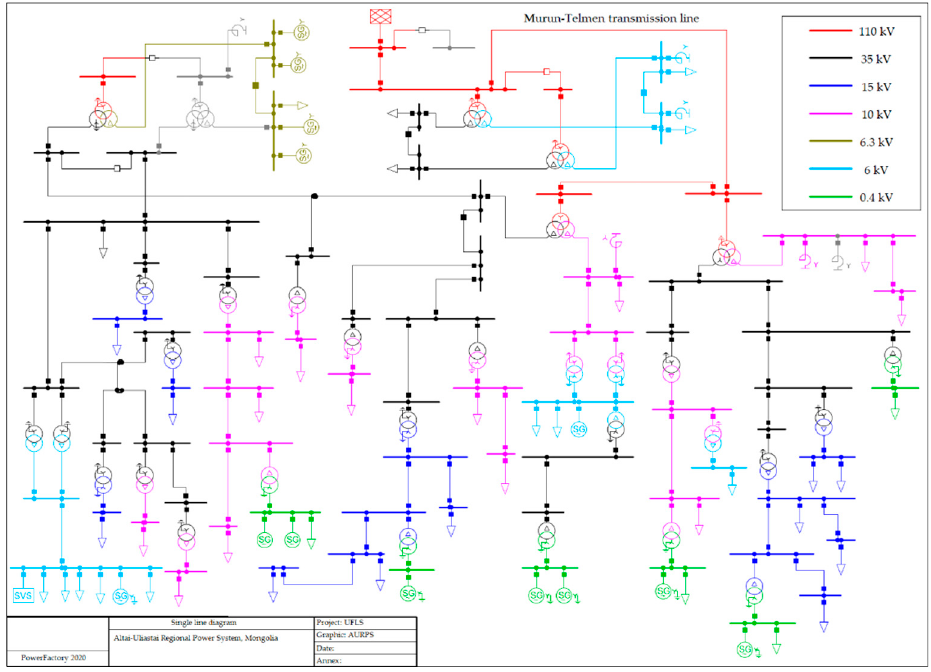
Figure 5. Schematic single-line diagram of Altai-Uliastai regional power system (AURPS).